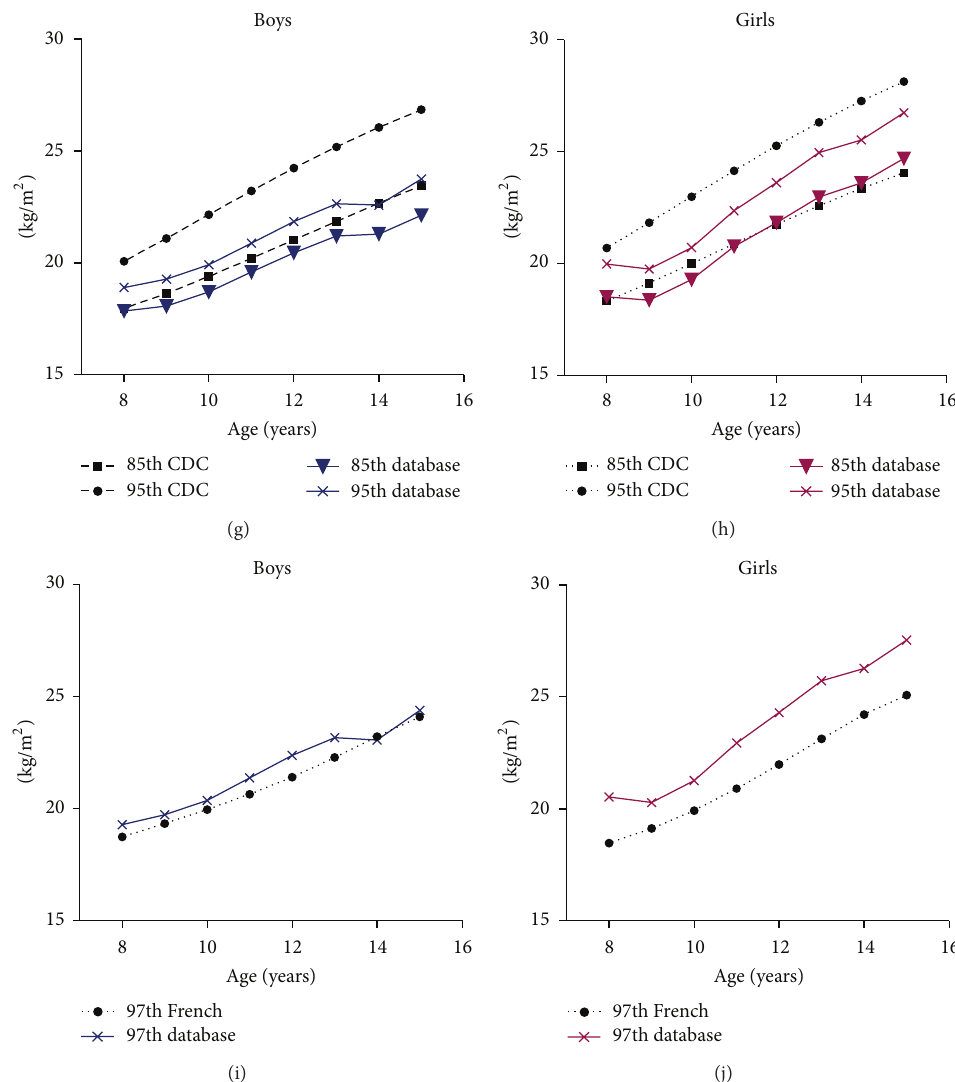
Figure 1: Comparison of age- and gender-specific body mass index (BMI) cut-off curves of our Database population of 8 to 15 years old presented relative to different published reference groups: International Obesity Task Force (IOTF) cutoffs for overweight and obesity matching, respectively, BMI of 25 and 30kg/m 2 at 18 years old (a and b), World Health Organization (WHO) 2007 85th and 95th percentiles (c and d), Must et al. or “old United States” 85th and 95th percentiles (e and f), Center of Disease Control (CDC) or “new United States” 85th and 95th percentiles (g and h), and Europe-French 97th percentile for overweight including obesity (i and j). In all panels, corresponding cutoffs derived from our Database are presented as solid lines presented beside reference cutoffs with dotted lines.